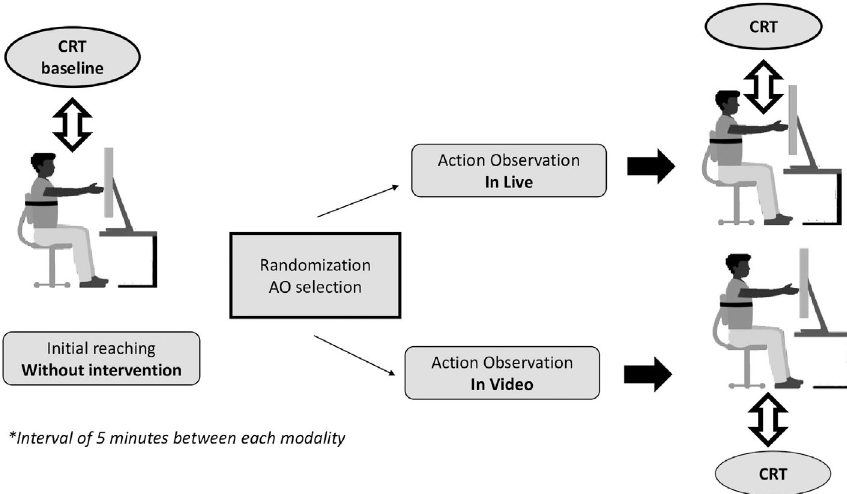
Figure 1 - Study design; Legends: CRT = choice reaction time; AO =